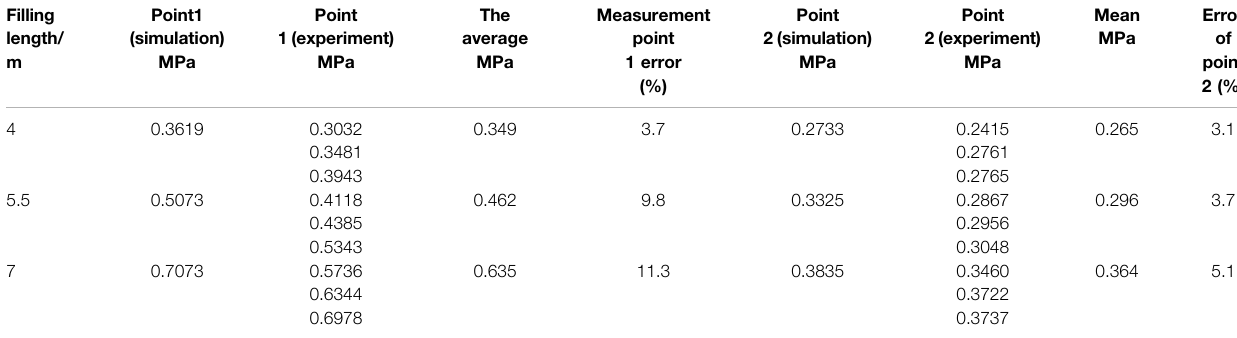
TABLE 1 | Comparison between simulation and experiment at different gas fi lling lengths. Filling